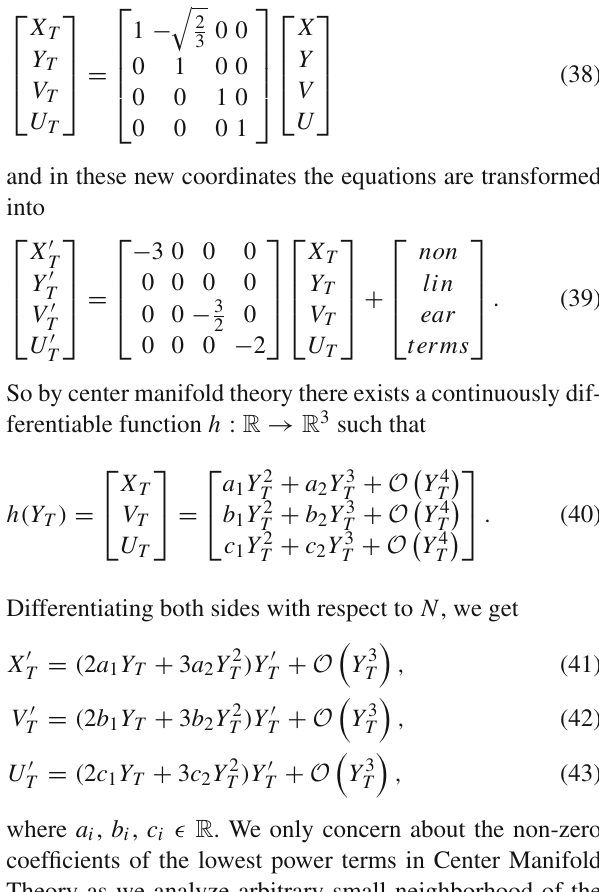
The eigenvalues of J ( C 2 ) are − 3, 0, − 3